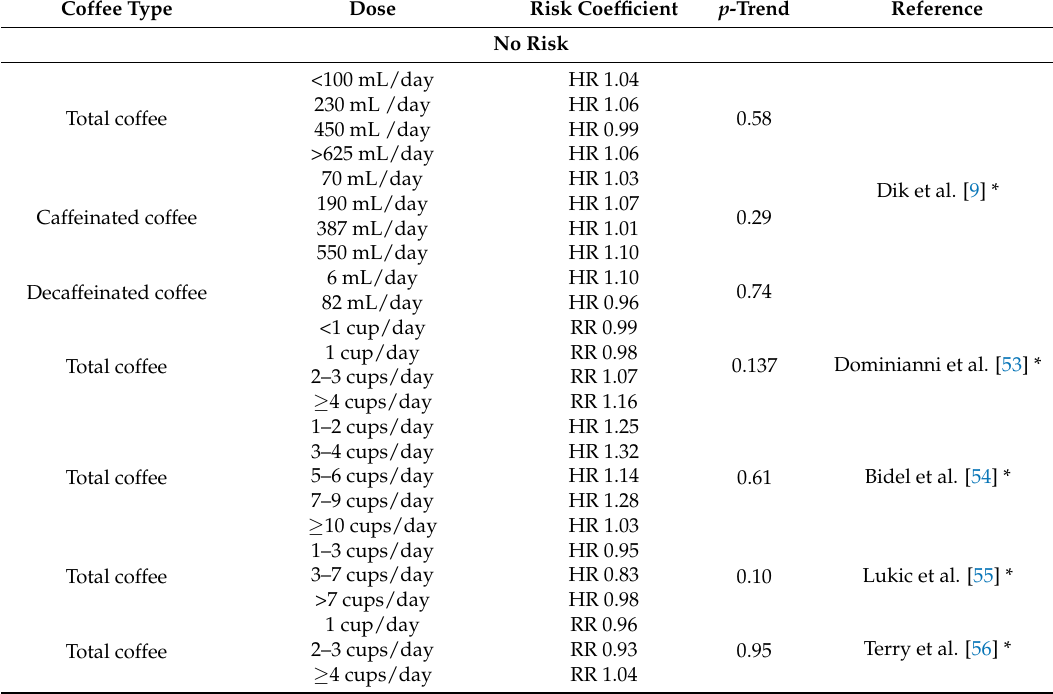
Table 1. The association between colorectal cancer risk and coffee consumption with risk coefficients for investigated coffee intake. Case–control and prospective cohort studies are distinguished with